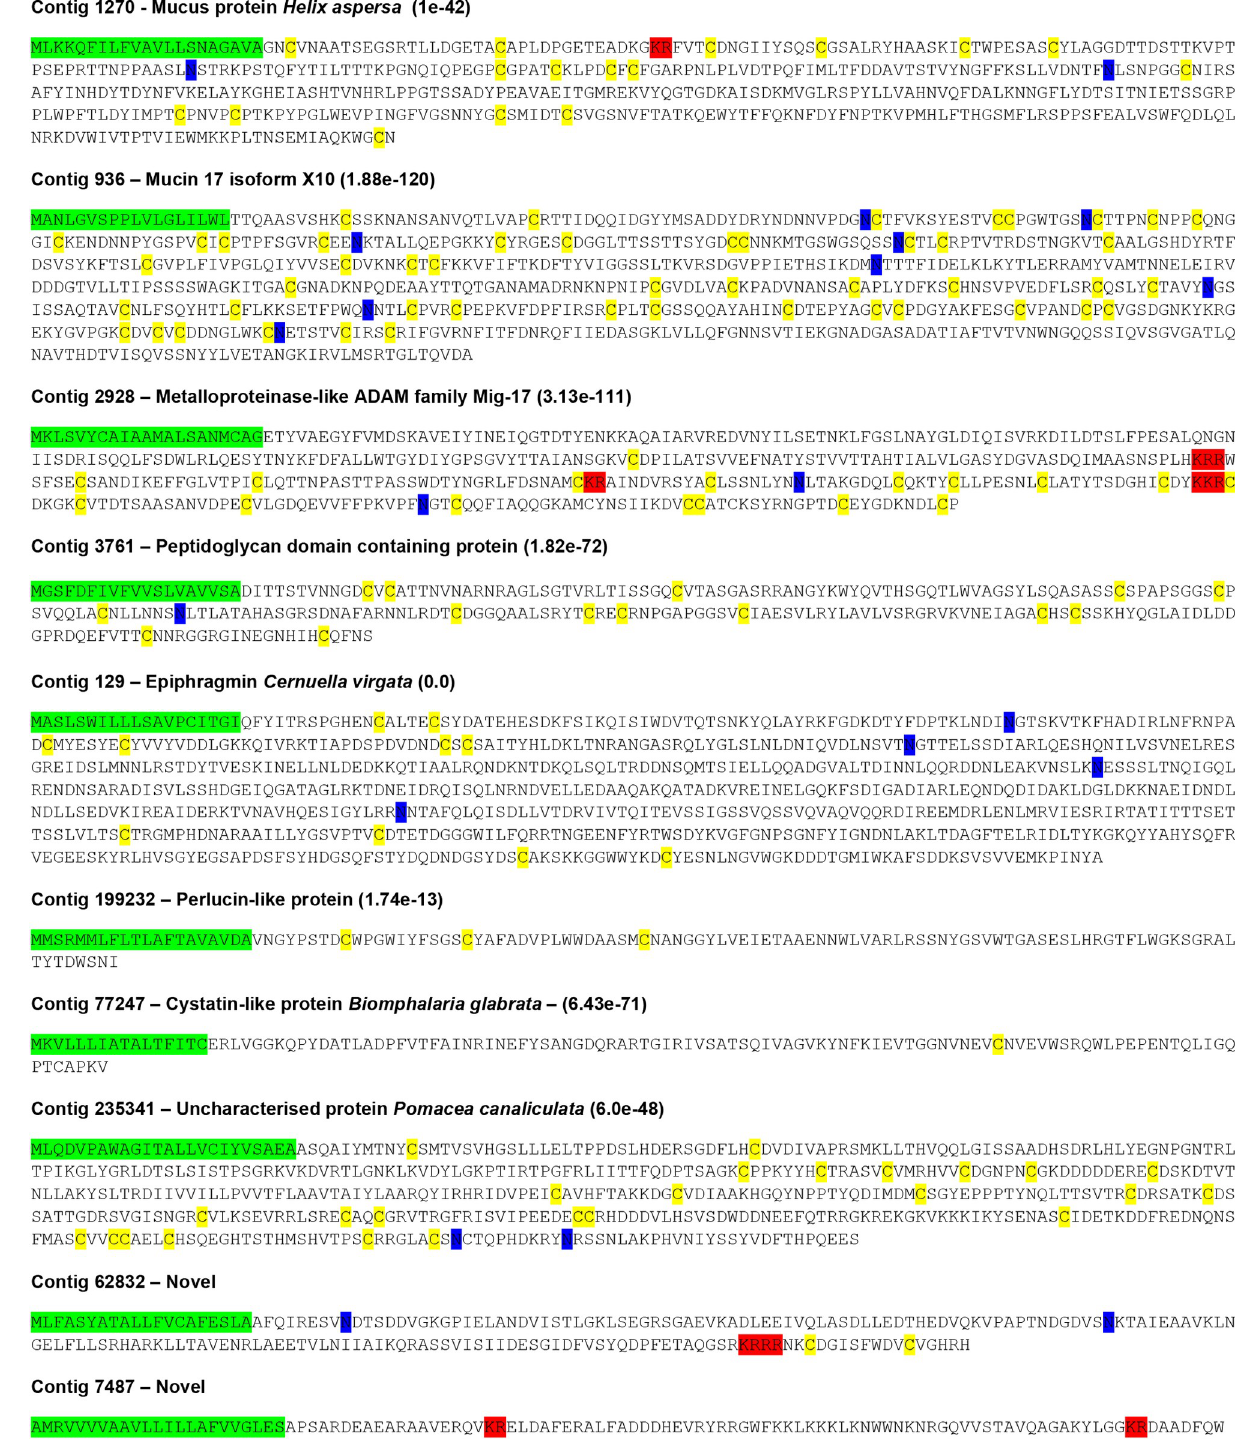
Fig 2. Annotation of full-length secreted proteins identified in trail mucus of C . aspersum . Yellow shading, cysteine residues; Blue shading, N- glycosylation sites; Green shading, signal sequences; Red shading, putative cleavage sites.